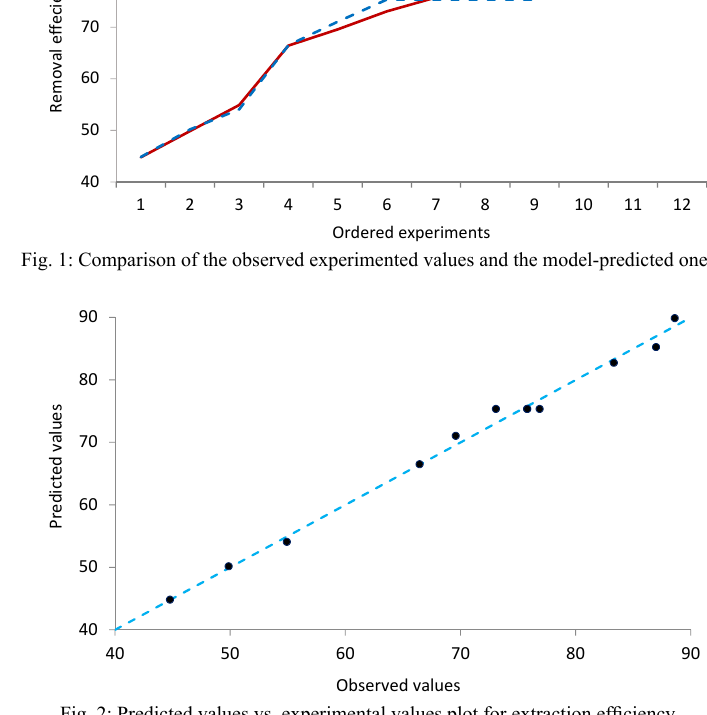
Fig. 2: Predicted values vs. experimental values plot for extraction